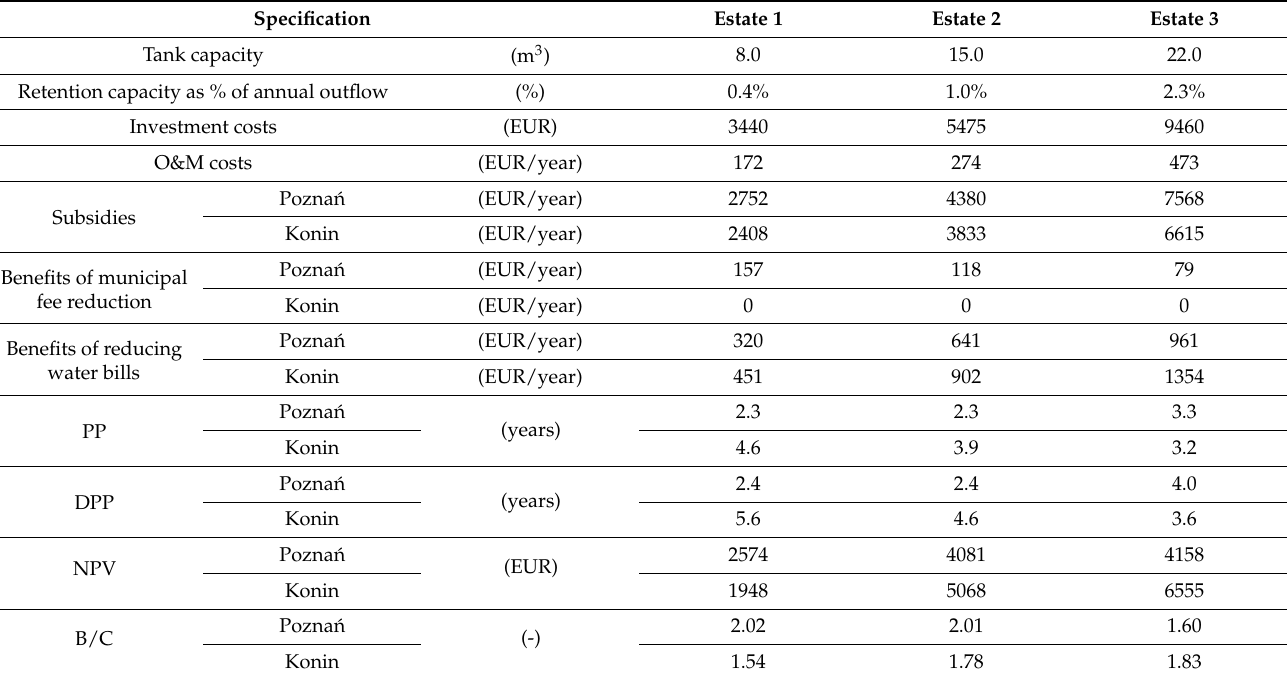
Table 19. Evaluation of the profitability of RWH strategy by taking into account subsidy